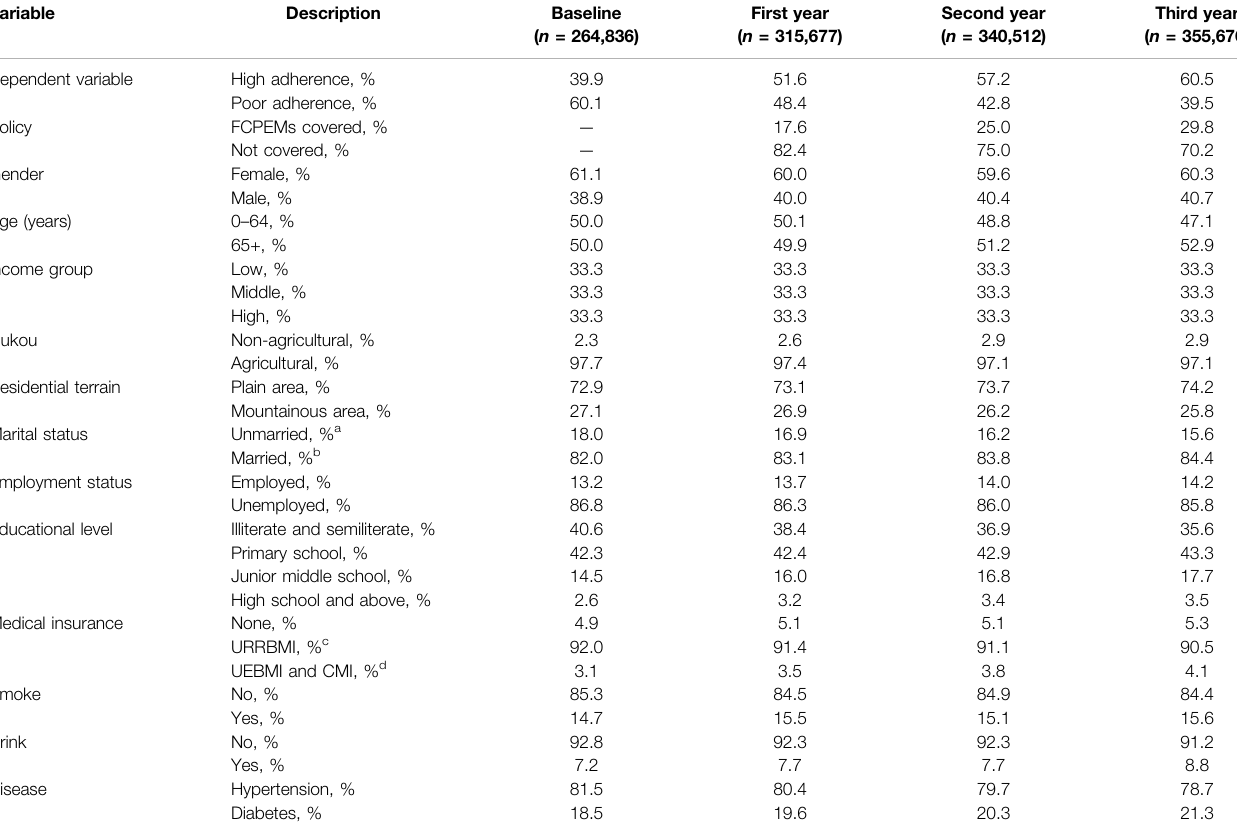
TABLE 1 | Characteristics of the study population in the 4 years.